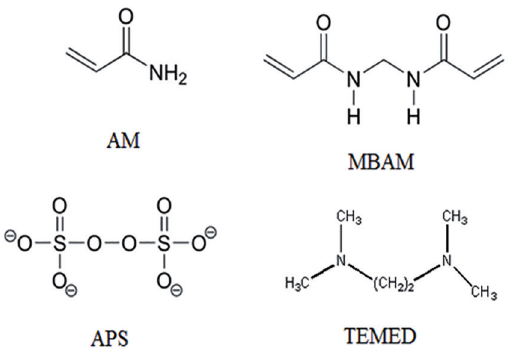
Figure 1: The molecular structures of monomer system components.